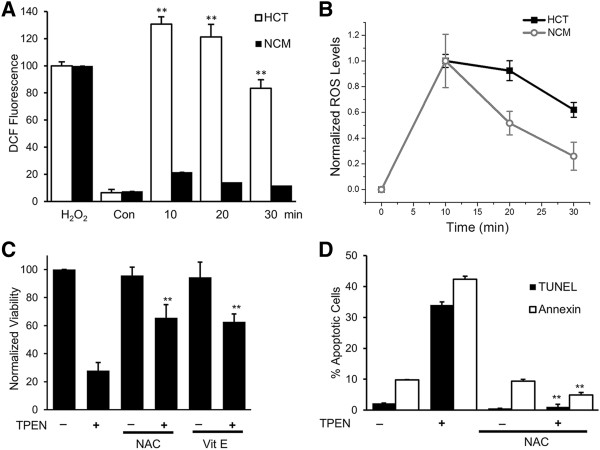
TPEN induces ROS generation in HCT116 cancer cells. A) Time course of TPEN-induced ROS generation in HCT116 and NCM460 cells. Control (Con) represents cells that have been treated with carrier DMSO. ROS generated in response to 250 μM H2O2 is also shown (mean ± SD, n = 3). B) Same data as in panel A) normalized to maximum levels of ROS induced in either the HCT116 or the NCM460 cells. Time zero represents carrier alone treatment and was set at zero. C) Cell viability in cells treated with TPEN in the presence or absence of the antioxidants NAC or vitamin E (mean ± SD, n = 3). D) Apoptosis measured using the TUNEL and Annexin assays in cells treated with TPEN in the presence and absence of NAC (mean ± SD, n = 3). ** p < 0.01, significant difference with respect to TPEN in C, and D, and with respect to control in A.